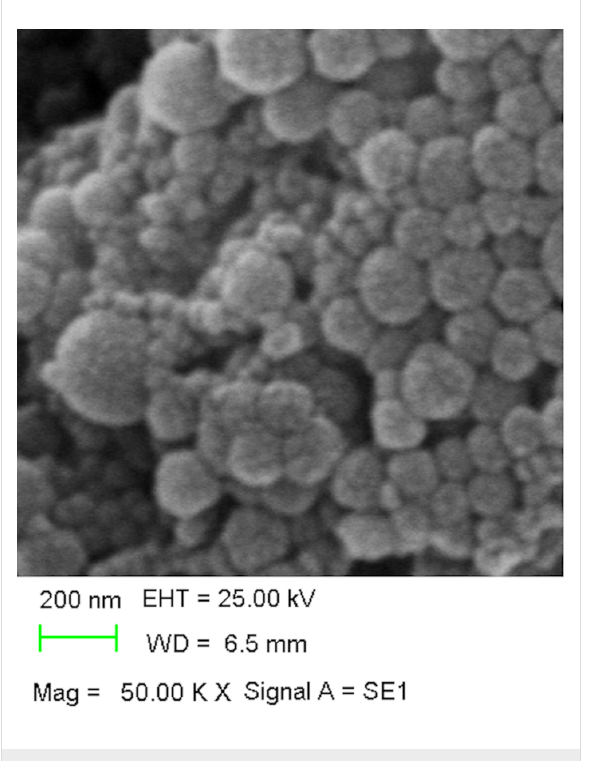
Figure 2: Scanning electron microscopy image of